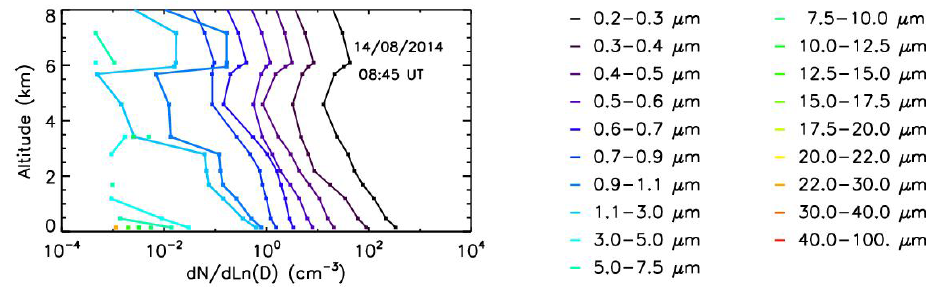
Figure 8. Typical vertical profile when no dust is present; flight from Aire sur l’Adour (south-west of France) on 14 August 2014.